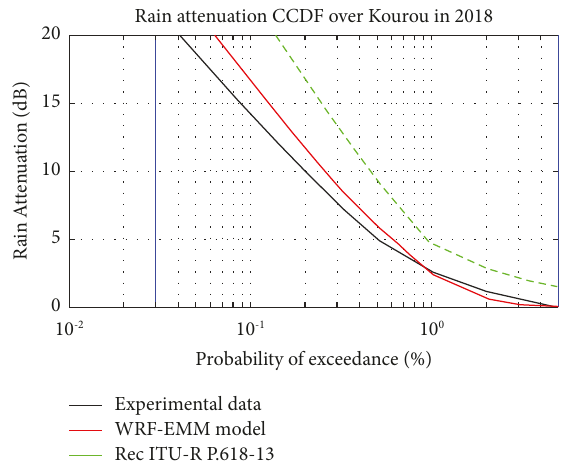
Figure 10: Comparisons between CCDFs computed from data measured in Kourou in 2018 (99.7% availability), WRF-EMM simulations and Rec. ITU-R P.618–13 using R 0.01 predicted with Rec. ITU-R P.837–7.